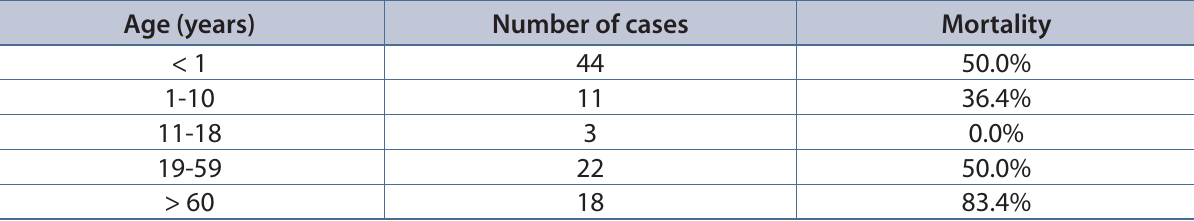
Table 3. Age-specific mortality rate in candidemia patients admitted to Botucatu Medical School University